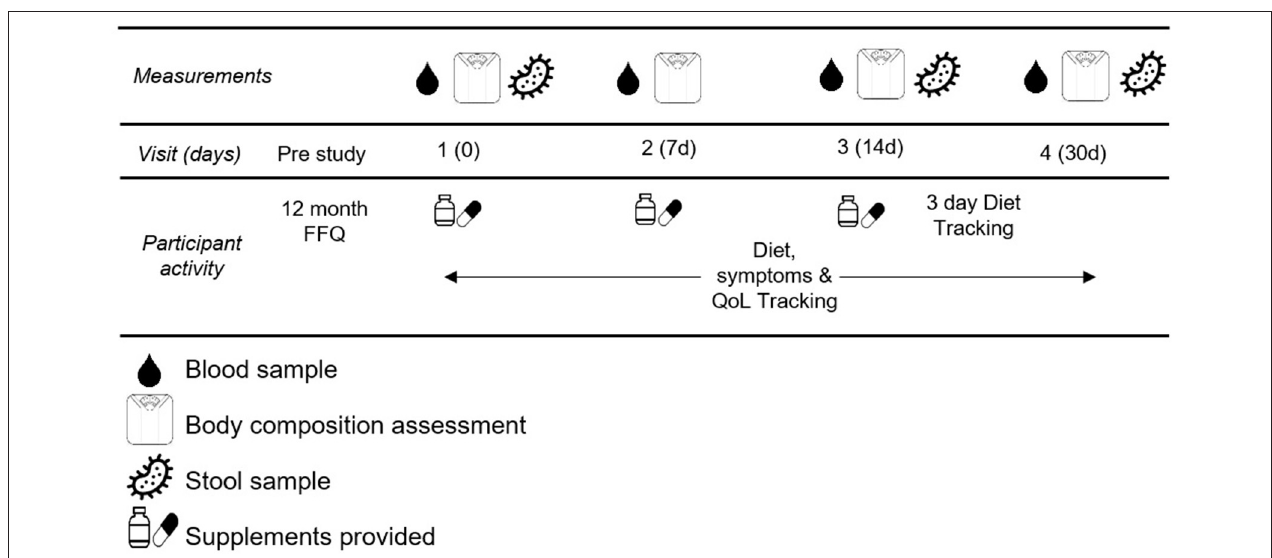
FIGURE 2 | Testing